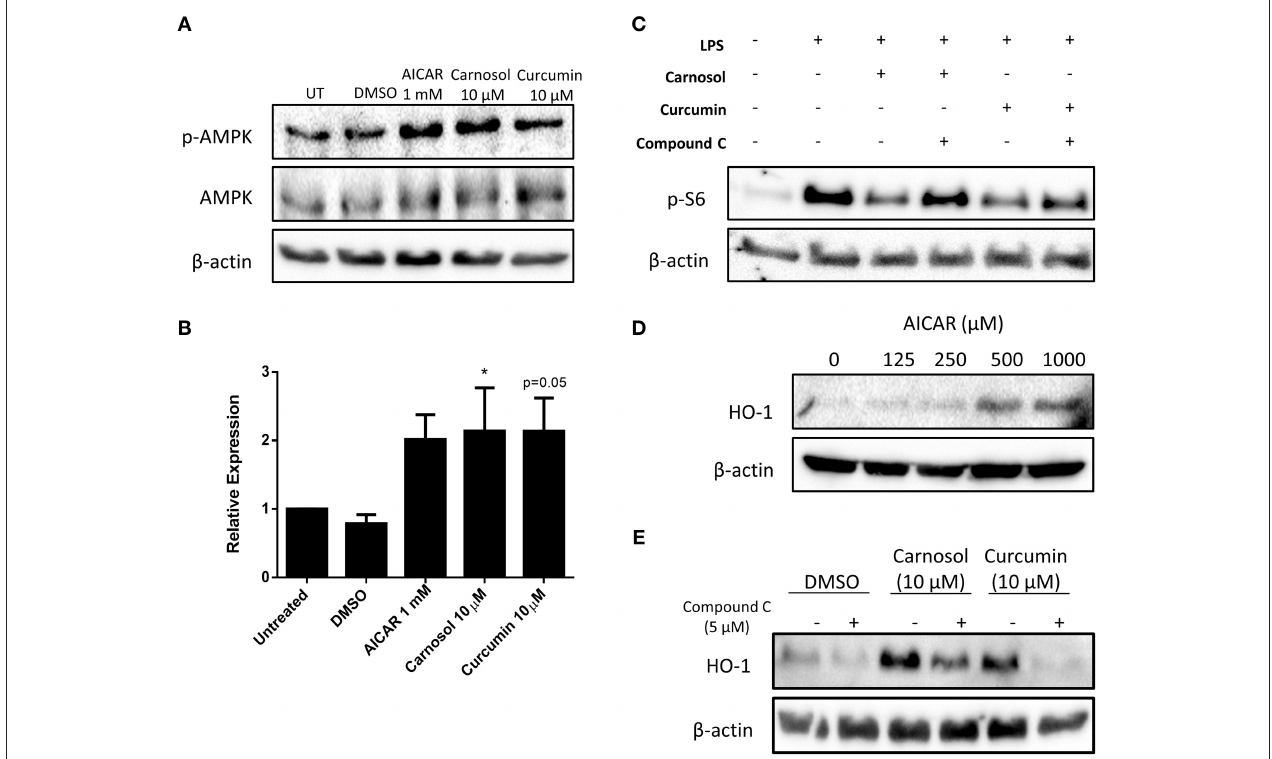
FIGURE 3 | Carnosol and curcumin inhibit mTOR activity and upregulate HO-1 expression in human DC via activation of AMPK. (A) Primary human DC were incubated with AICAR (1mM), carnosol (10 µ M), curcumin (10 µ M), or a vehicle control for 1h. Activation of AMPK was measured by Western blot. (B) Pooled data ( n = 7) depicting densitometric analysis of phospho-AMPK expression relative to the loading control. (C) Primary human DC were incubated with compound C (5 µ M) for 1h prior to treatment with carnosol (10 µ M) or curcumin (10 µ M) for 1h, followed by stimulation with LPS (100ng/ml) for 1h. Expression of phospho-S6 was determined by Western blot. (D) Primary human DC were incubated with AICAR (125–1,000 µ M) for 24h. Expression of HO-1 was detected by Western blot. (E) Primary human DC were incubated with compound C (5 µ M) for 1h prior to treatment with carnosol (10 µ M) or curcumin (10 µ M), or a vehicle control for 24h. Expression of HO-1 was detected by Western blot. All blots depict an individual donor and are representative of 3–7 independent experiments. Blots shown are derived from the same gel(s); membranes were first probed for the protein of interest and then re-probed for β -actin as a loading control. Full-length blots are presented in Supplementary Figures 1 , 2 . Statistical significance was determined by one-way ANOVA with Dunnett’s multiple comparisons post hoc test to compare treatment groups against the control group (* p <